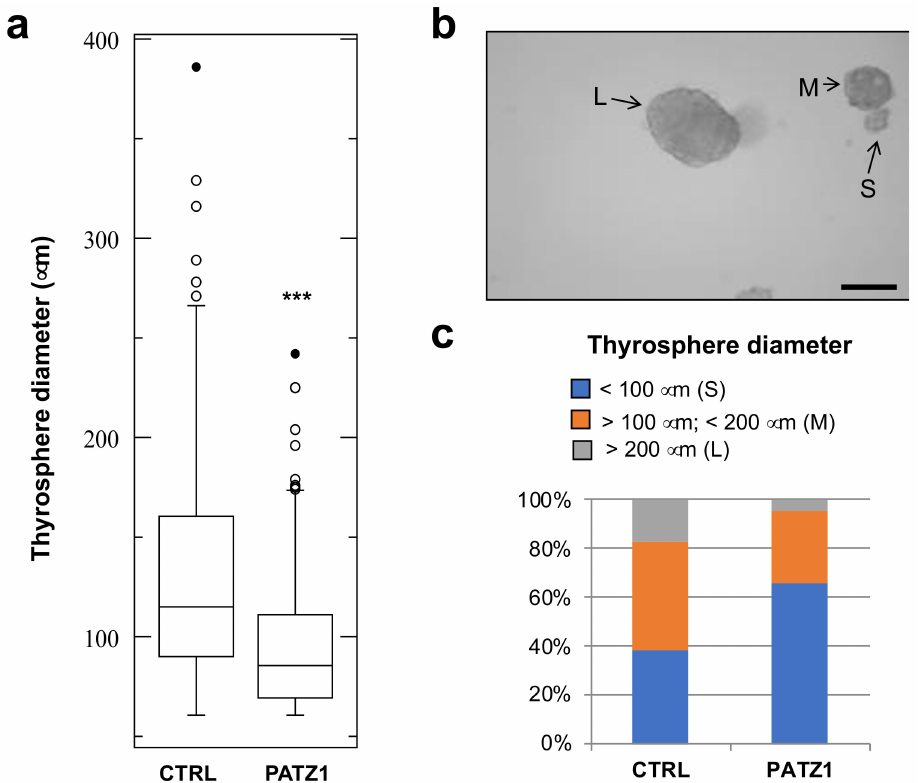
Figure 4. Thyrosphere diameter evaluation. ( a ) Boxplot showing diameter of secondary thyrospheres in two independent clones and two independent experiments for each control and PATZ1 expressing FRTL5-Ras cell line at 14 days from plating. The graph shows median values ± SD of all spheres with a diameter > 60 µ m. ***, P < 0.0001. ( b ) Representative image of FRTL-Ras-Ctrl thyrospheres showing different size. L = large sphere (diameter > 200 µ m); M = middle sphere (diameter > 100 µ m < 200 µ m); S = small sphere (diameter < 100 µ m). Scale bar: 200 µ m. ( c ) Distribution of the three thyrosphere subgroups in FRTL5-Ras-Ctrl (CTRL) and FRTL5-Ras-PATZ1 (PATZ1)